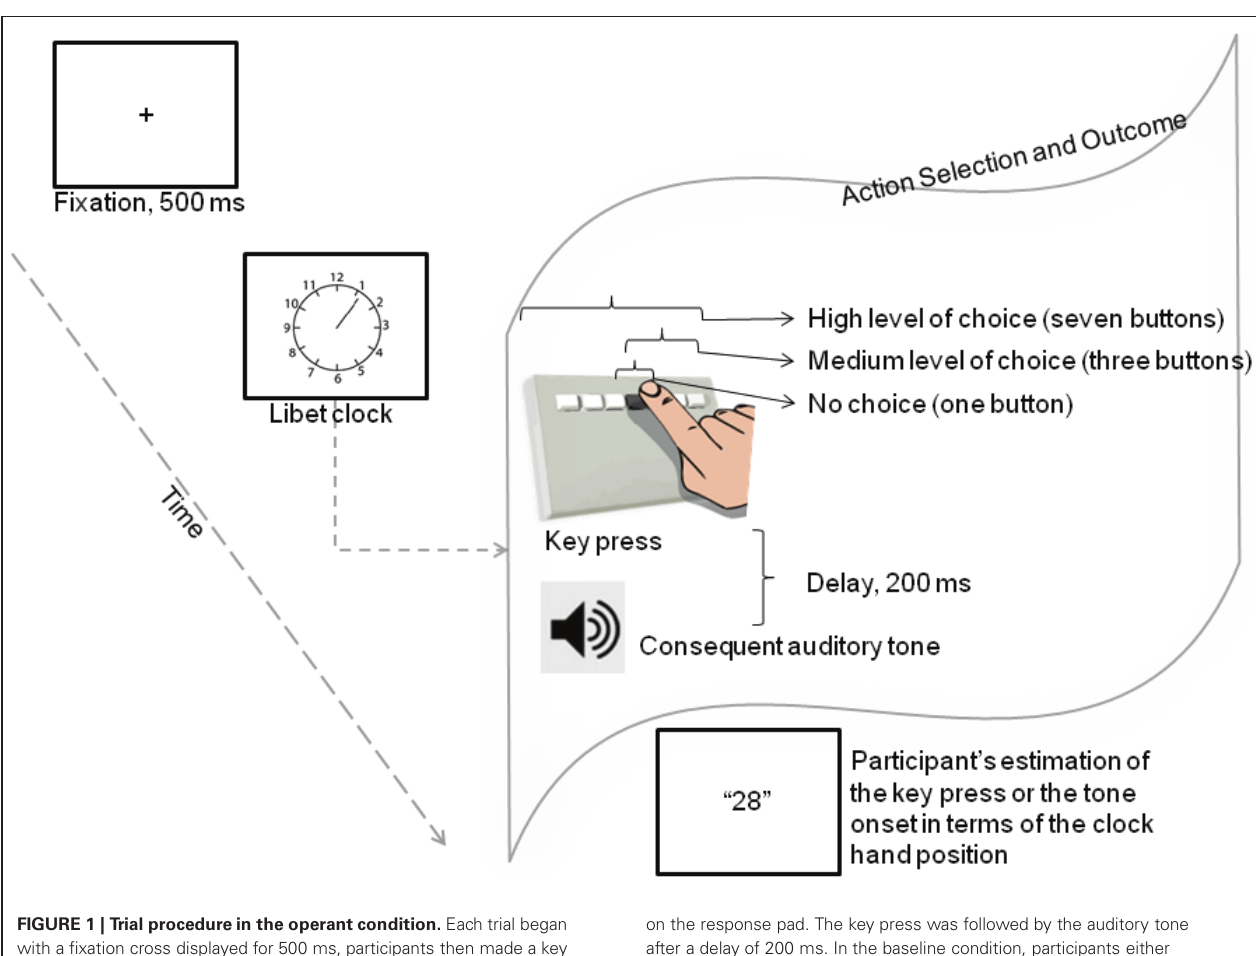
FIGURE 1 | Trial procedure in the operant condition. Each trial began with a fixation cross displayed for 500 ms, participants then made a key press at their own pace after the clock started rotating. They were told to press a specific button in the no-choice condition or select one of three (medium level of choice) or seven (high level of choice) buttons